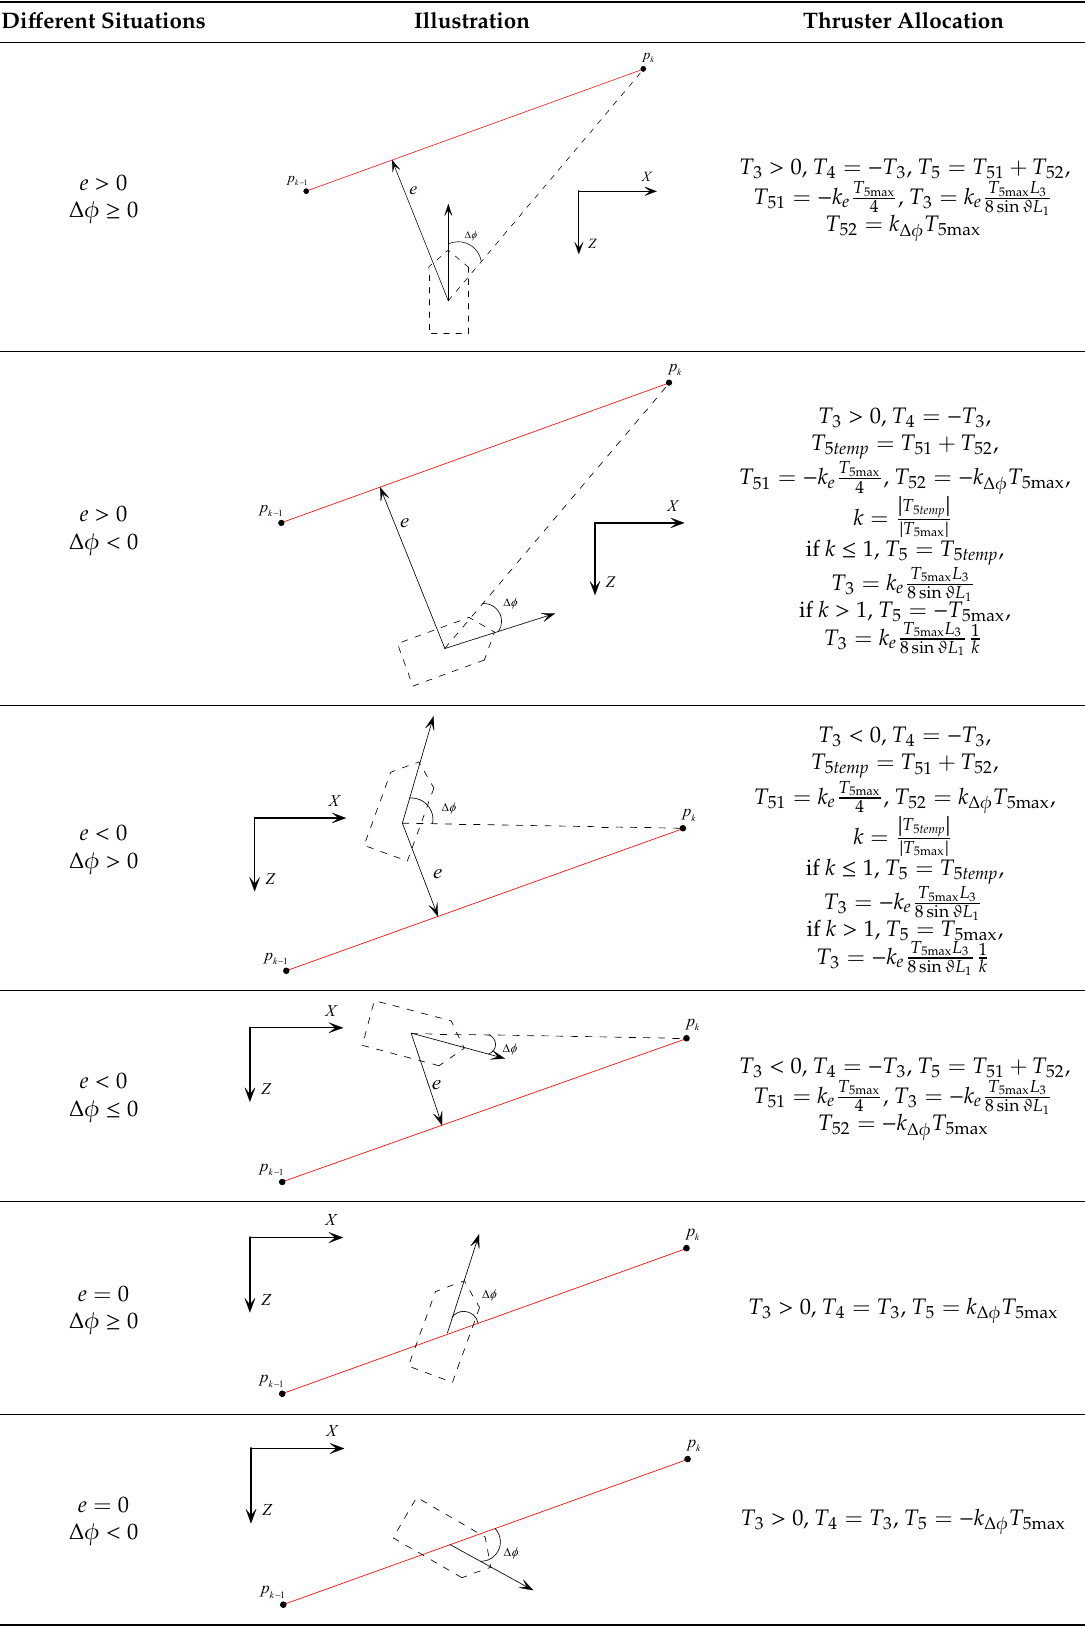
Table 5. Thruster Table 5. Thruster allocation. Table 5. Thruster allocation.